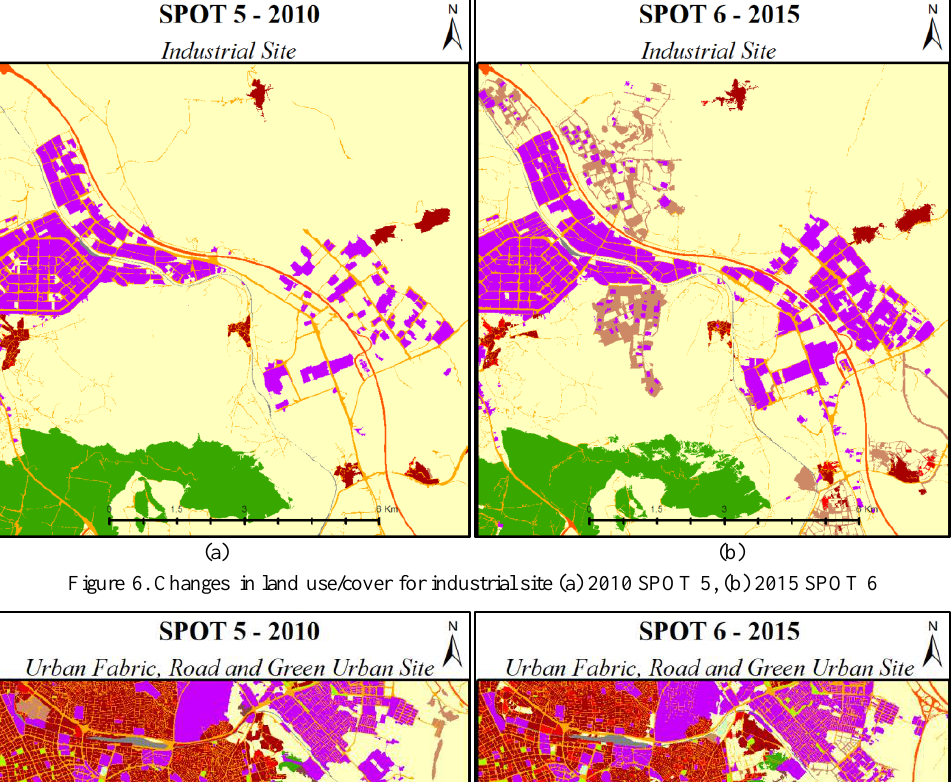
Figure 6. Changes in land use/cover for industrial site (a) 2010 SPOT 5, (b) 2015 SPOT 6